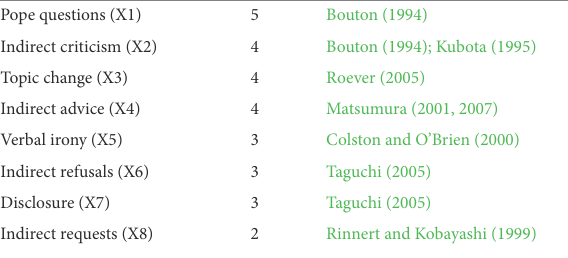
Implied meaning number of test items